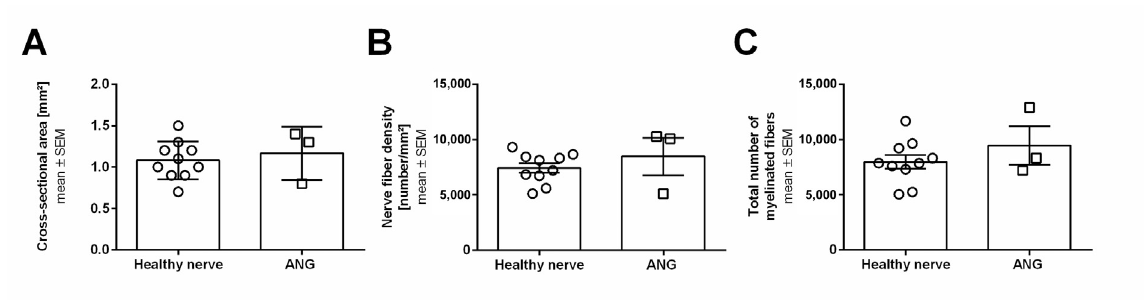
Fig. 4 Scatter plot with bar graphs displaying results from histomorphometrical analyses of distal nerve segments from healthy or autologous nerve graft reconstructed sciatic nerves at 6 months of postsurgery. Cross-sectional areas ( A ), nerve fi ber densities ( B ), and total numbers of myelinated fi bers ( C ) are shown. No signi fi cant differences ( p < 0.05) were detected by Mann – Whitney test. Results are presented as mean (cid:4) SEM (healthy nerve: n ¼ 10; ANG: n ¼ 3). ANG, autologous nerve graft; SEM, standard error of mean.